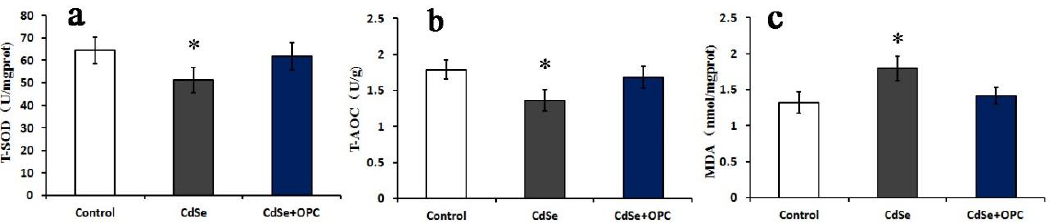
Figure 7. The bar graph showing T-SOD ( a ), T-AOC activity ( b ), and MDA content ( c ) in A549 cells. They were measured using microplate readers represented as mean ± SD. (* p < 0.05, as compared with the normal control groups).